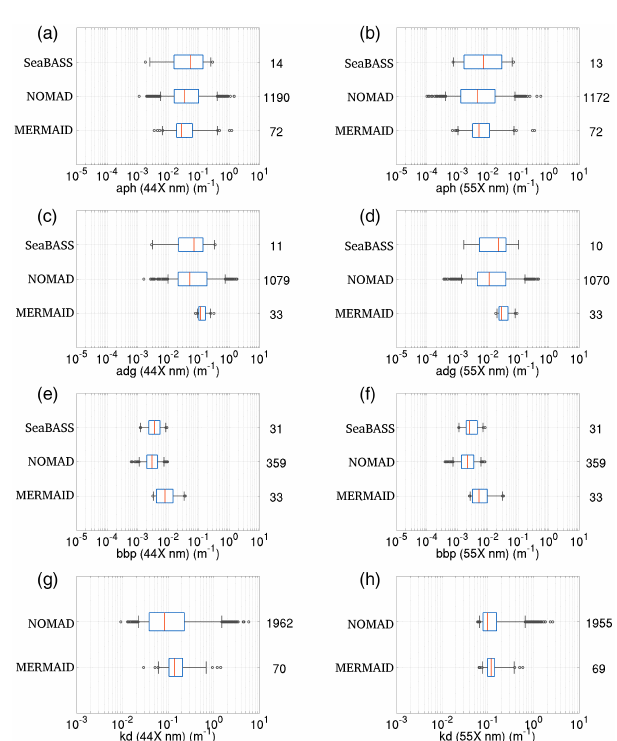
Figure 12. The distribution of (a) aph at 44 X nm, (b) aph at 55 X nm, (c) adg at 44 X nm, (d) adg at 55 X nm, (e) bbp at 44 X nm, (f) bbp at 55 X nm, (g) kd at 44 X nm and (h) kd at 55 X nm. Data were first searched at 445 and 555nm and then with a search win- dow of up to 8nm to include data at 547nm. The graphical conven- tion is identical to Fig.